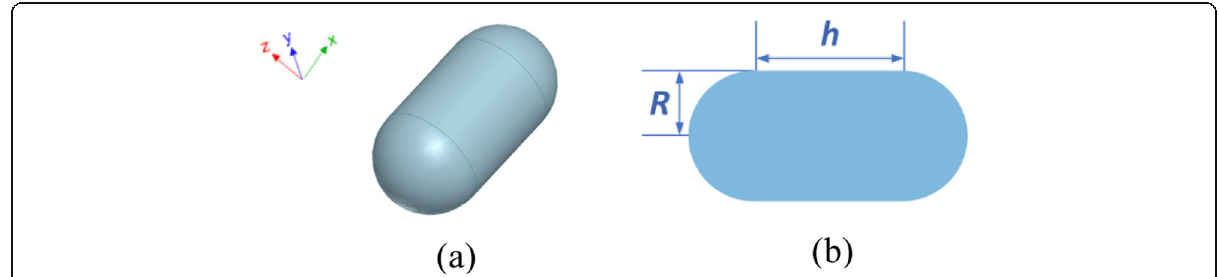
Fig. 3 Configuration of a silver nanocapsule structure. a 3D view. b Front view and dimensions, where R = 30 nm and h = 60